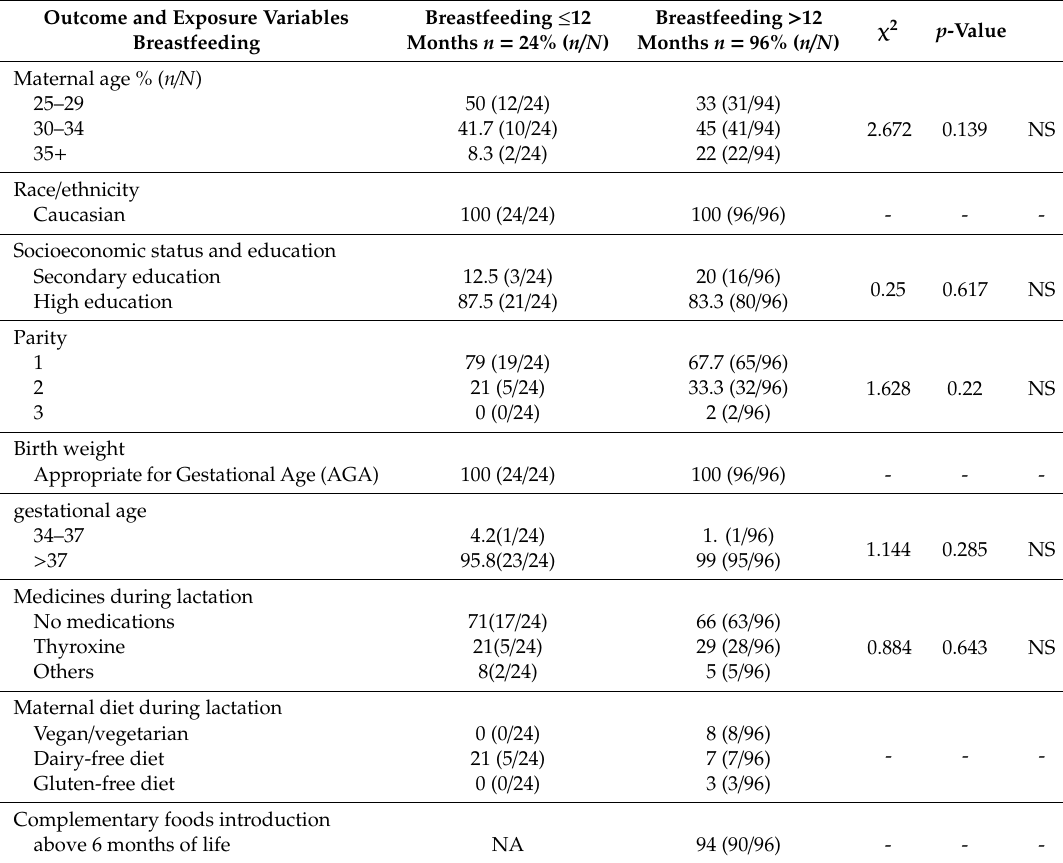
Table 1. Characteristics of the study